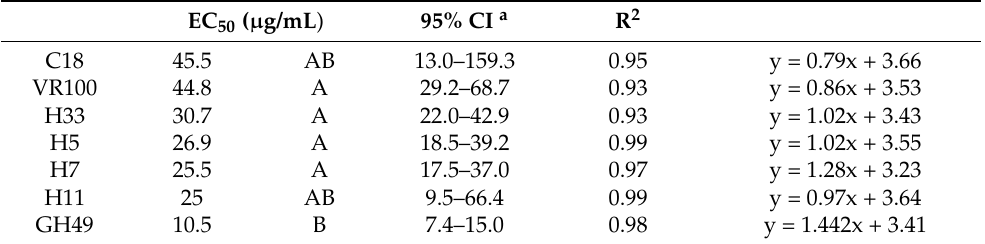
Table 2. Chlorothalonil mean EC 50 values (effective fungicide concentration that inhibited mycelial growth by 50%) for Phytophthora palmivora isolates from Ghana (GH49 and VR100), Mexico (C18), and Hawaii (H5, H7, H11, and H33) obtained from in vitro assays. Mean separation is based upon whether confidence intervals overlap, columns with the same letter are not significantly different. EC 50 ( µ g/mL ) 95% CI a